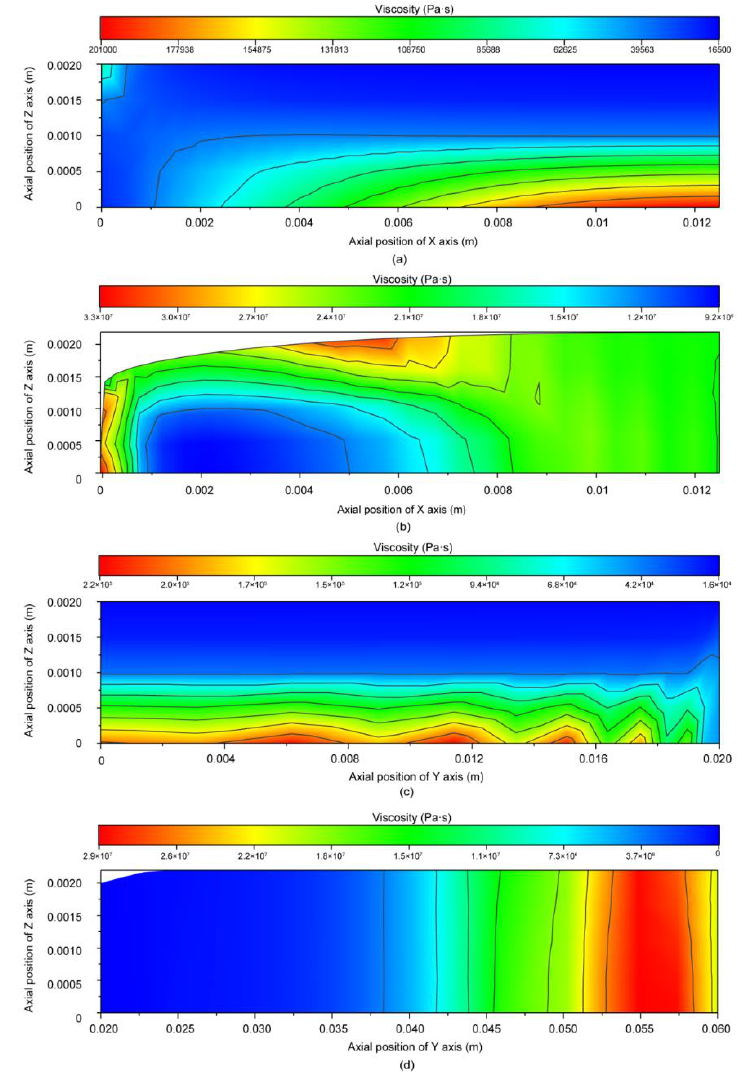
Figure 6. The viscosity field distribution using the WPC with 40% wood fiber as an example. Distribution of viscosity at: ( b ) the inlet; ( b ) the outlet; ( c ) on the plane of symmetry 1; ( d ) on the plane of symmetry